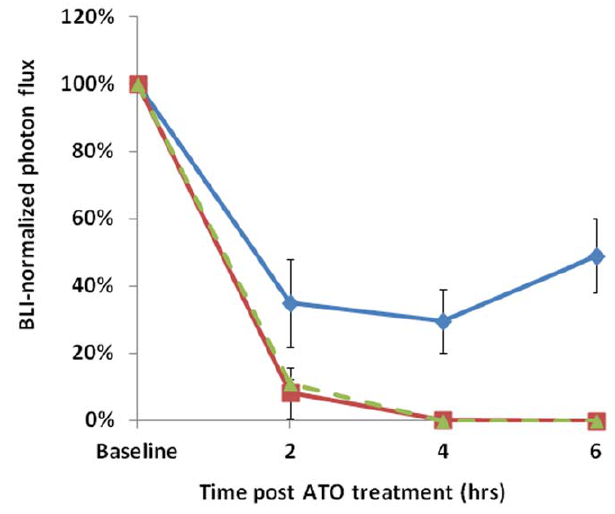
Figure 5. Comparative vascular shutdown following ATO (8 mg/kg) to mice bearing various tumors. Relative BLI signal intensity observed for tumors 10 mins after administration of luciferin with respect to drug treatment in three different types: blue ¤ MCF7- mCherry-luc; green m U87-mCherry-luc; red & PC3-luc; mean values 6 SE.